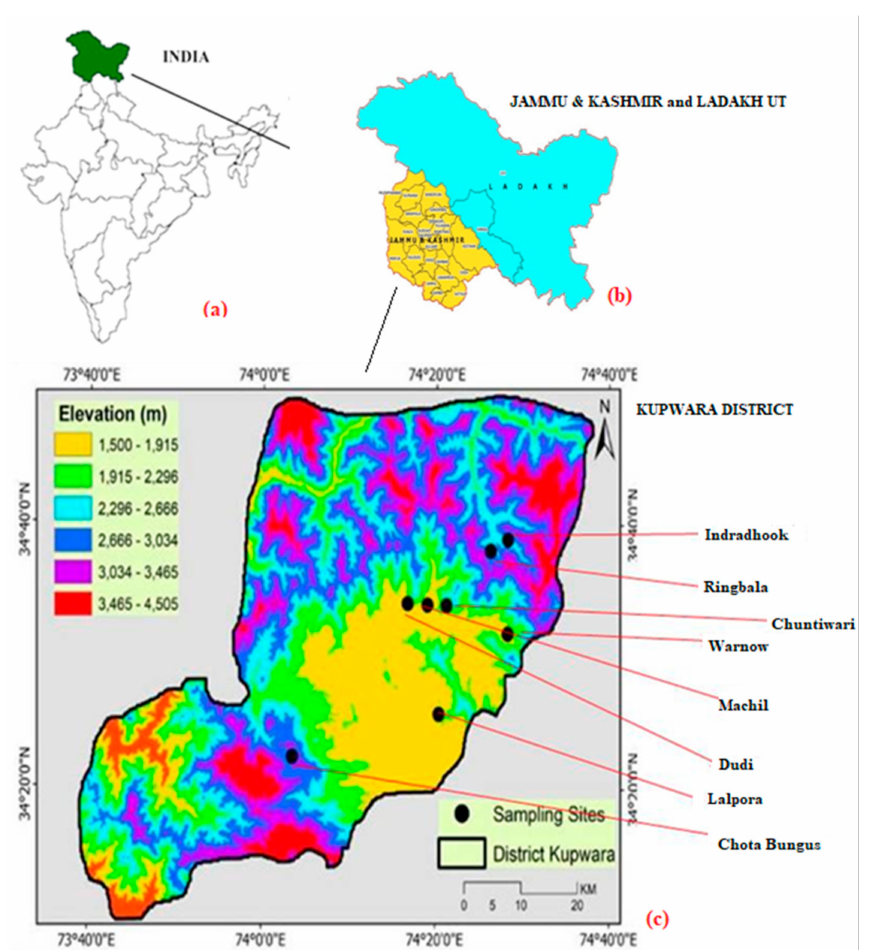
Figure 1. Location map of the study area prepared with the help of ArcGIS (8.1–8.3 Desk top). ( a ) India. ( b ) Jammu & Kashmir and Ladakh ut. ( c ) Kupwara District. (black dots represent the sampling sites with elevations that were visited for data collection).